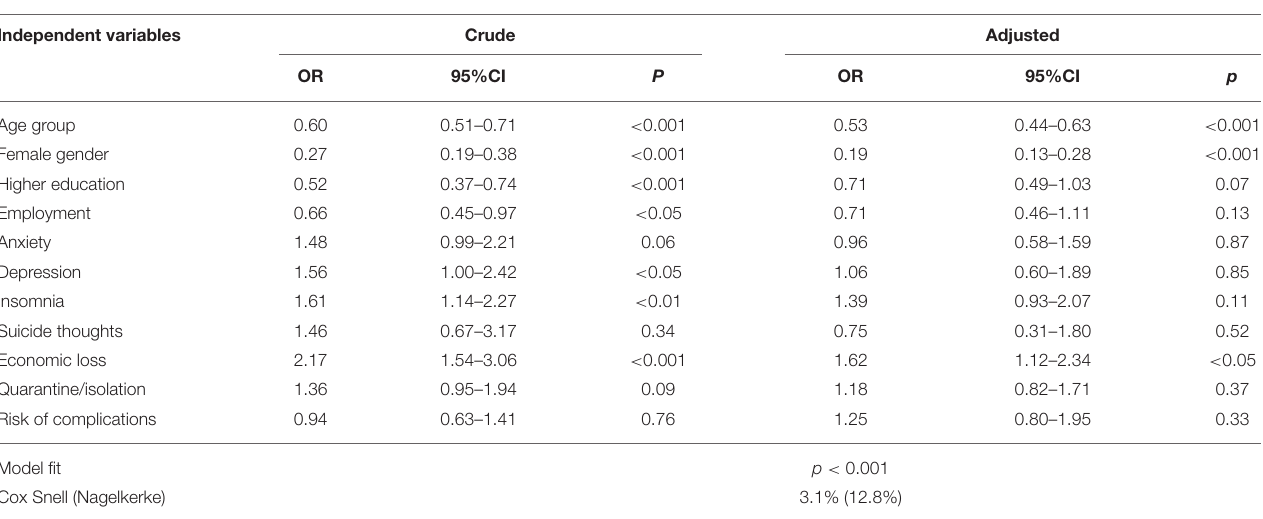
TABLE 3 | Associations with use of